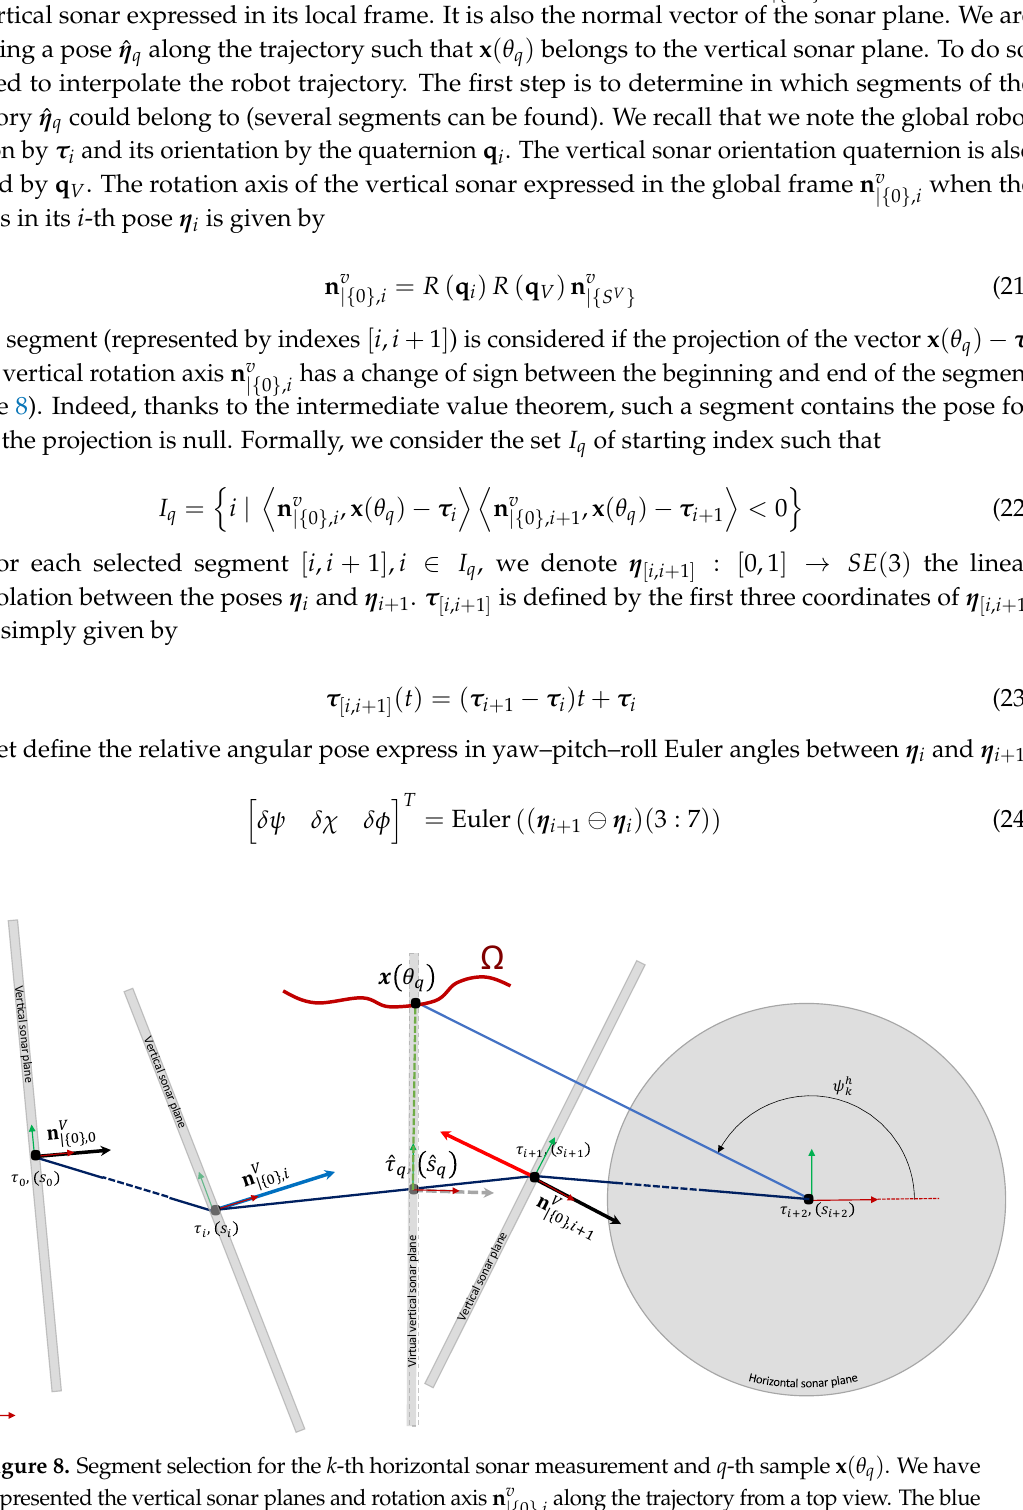
along the trajectory from a top view. The blue 0 , i |{ }